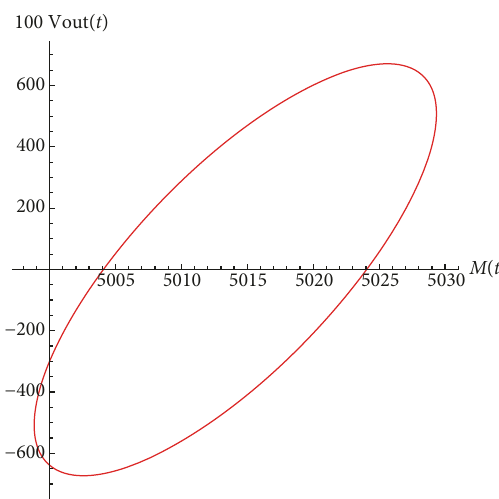
Figure 28: 𝑉 𝑜𝑢𝑡 (𝑡) versus 𝑀(𝑡) of Type A Wien oscillator: fractional memristor with 𝛼 = 1.25